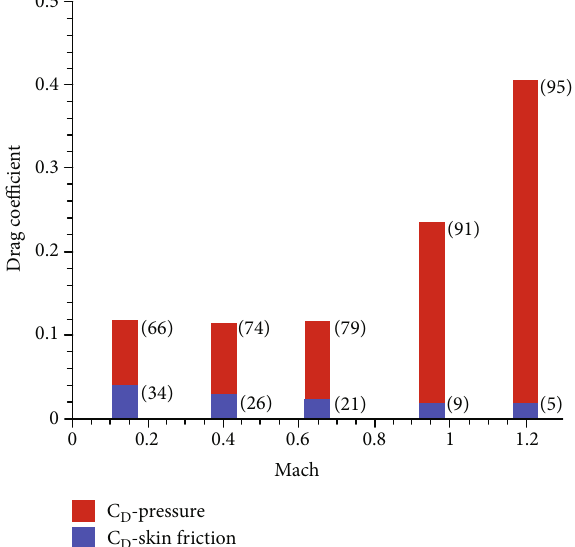
Figure 7: Total drag (pressure drag + skin friction drag) coe ffi cients.